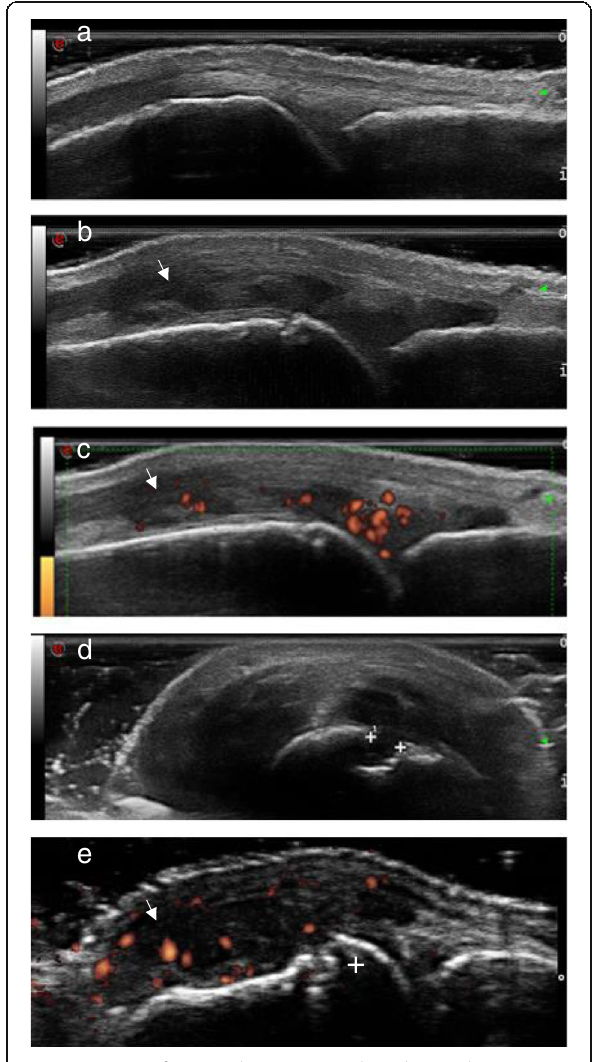
Fig. 1 Imagens of a normal MCP joint and an abnormal MCP joint of a RA patient. a Normal musculoskeletal ultrasound (MSUS) of third metacarpophalangeal (MCP) joint, longitudinal dorsal aspect; b Synovial proliferation grade 3 on second MCP, longitudinal dorsal aspect (arrow in hypoechoic area); c Synovial proliferation (arrow) and power Doppler (pD) captation grade 2 on second MCP, longitudinal dorsal aspect; d Interruption of cortical bone (erosion) on second MCP, radial aspect, longitudinal scan (plus sign); e MSUS of a patient with long-standing rheumatoid arthritis. Findings of second MCP (longitudinal dorsal aspect) include synovial proliferation grade 3 (arrow), pDcaptation grade 2 and bone